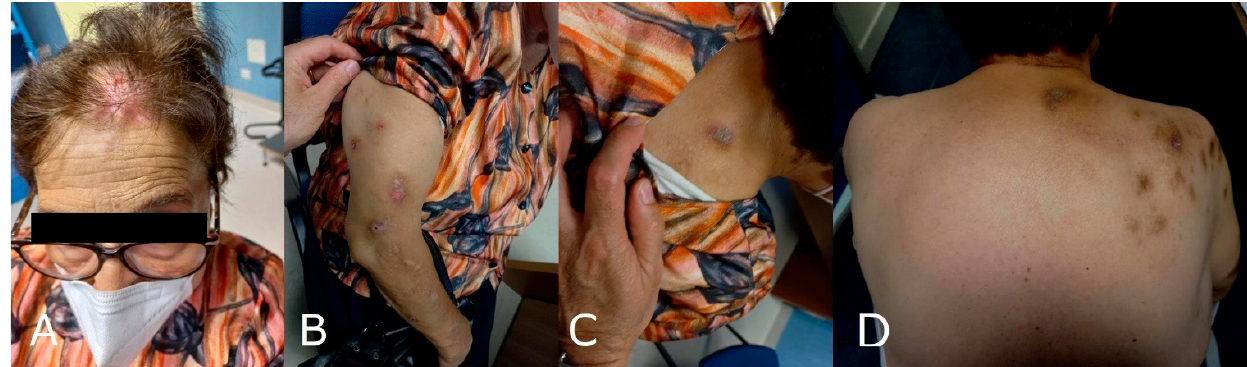
Figure 1. An axial FLAIR-weighted MRI image showing a hyperintense area (white arrow) in the left lateral medulla, suggestive of infarct.